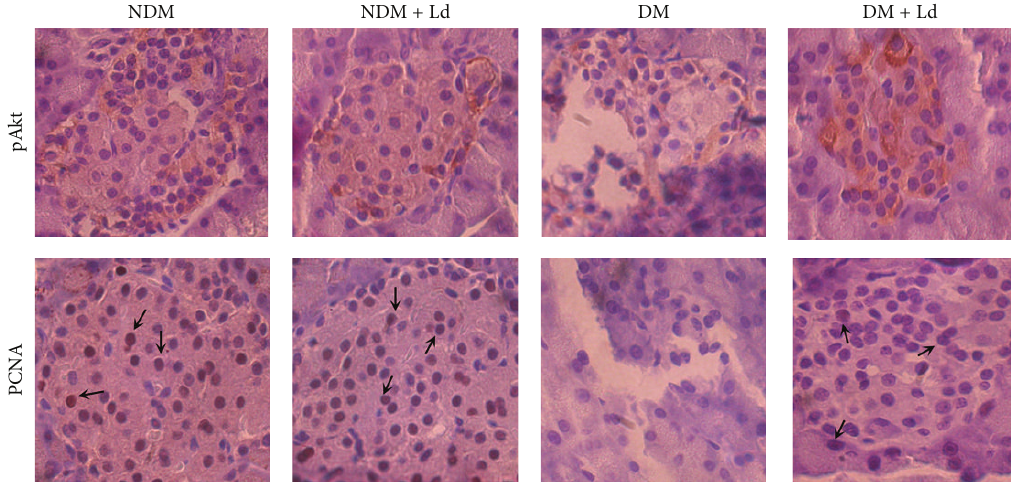
Figure 5: The effect of L. deterrimus extract administration on the prosurvival pathway and 𝛽 -cell proliferation in pancreatic islets. Light photomicrographs of immunohistochemical staining for pAkt and PCNA of pancreatic sections within the islet (magnification 40x). NDM + Ld: control rats treated daily with L. deterrimus extract for four weeks; DM: STZ-induced diabetic rats; DM + Ld: STZ-induced diabetic rats treated with L. deterrimus extract for four